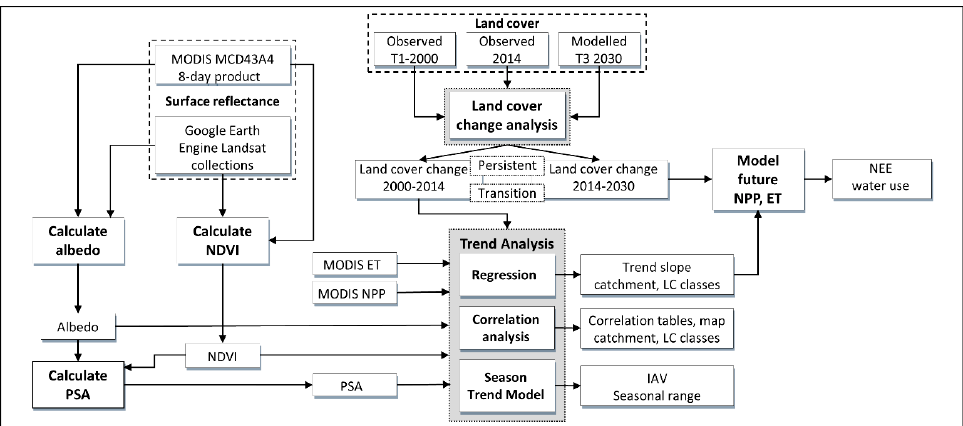
Figure 2. Processing flow to model albedo relationship with land cover.